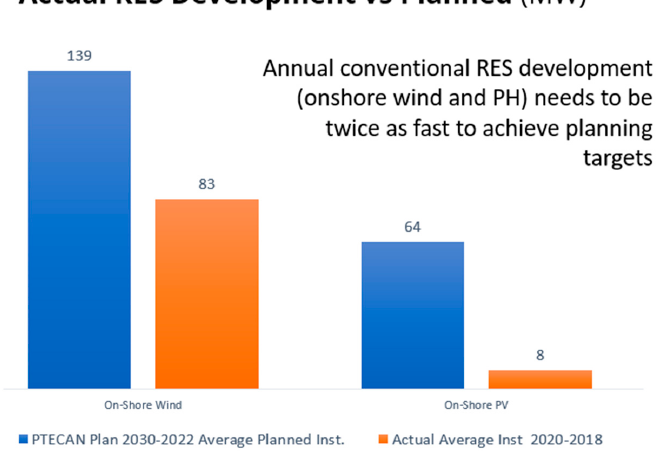
Figure 9. RES yearly installation breakdown of conventional RES.